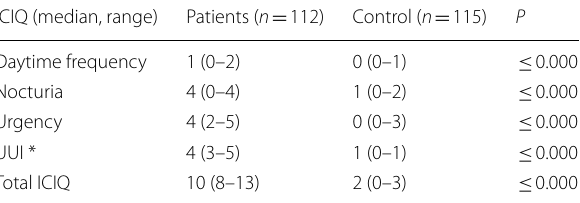
Table 2 Discrimination properties of the Arabic ICIQ between patients with OAB and controls